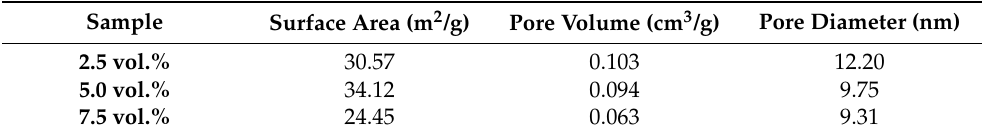
Figure 5. Pore size distribution and N 2 isotherm adsorption-desorption curve (5.0 vol.%) of grafted NH 2 -Al/MCM-41 with different amine functional groups. Table 4. The pore structure parameters of grafted NH 2 -Al/MCM-41 with different amine functional groups.